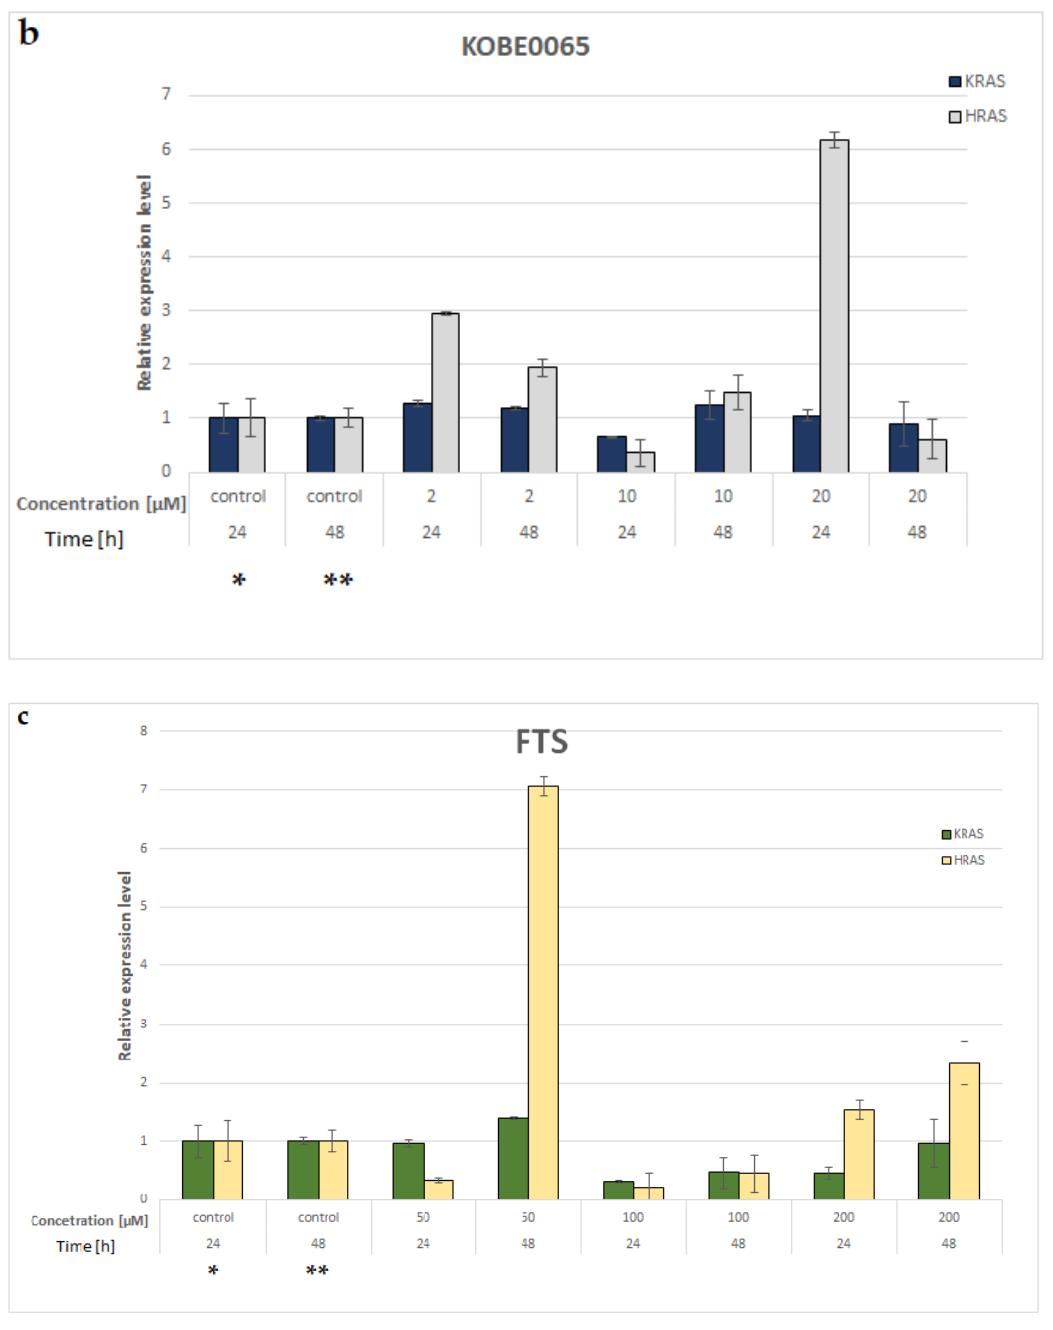
Figure 7. The relative mRNA expression levels of HRAS and KRAS genes in A549 cell line after incubation with different concentrations of deltarasin ( a ), Kobe0065 ( b ) and FTS ( c ) (* — calibrator for samples after 24-h of incubation; ** — calibrator for samples after 48 h of incubation).